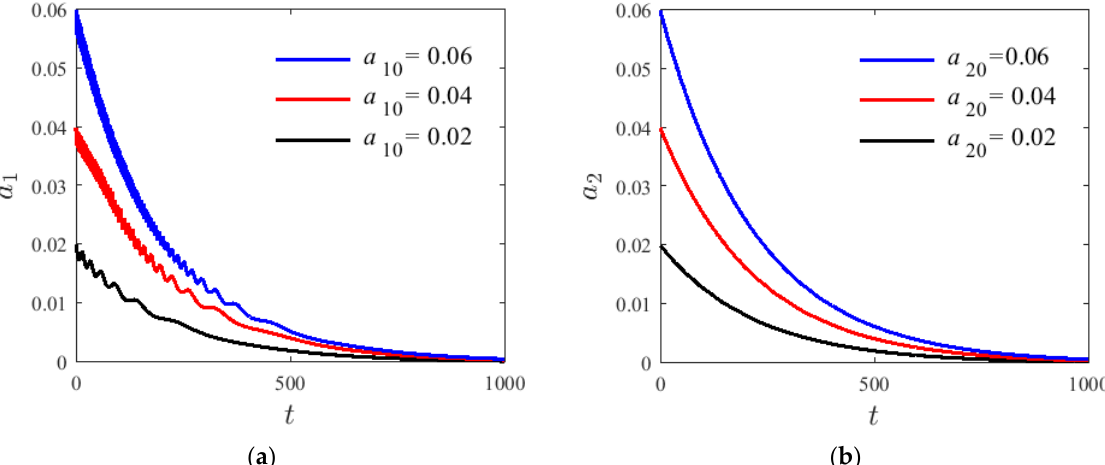
Figure 8. The decay graphs of variation modes for different initial conditions; ( a ) modal amplitude of a 1 , ( b ) modal amplitude of